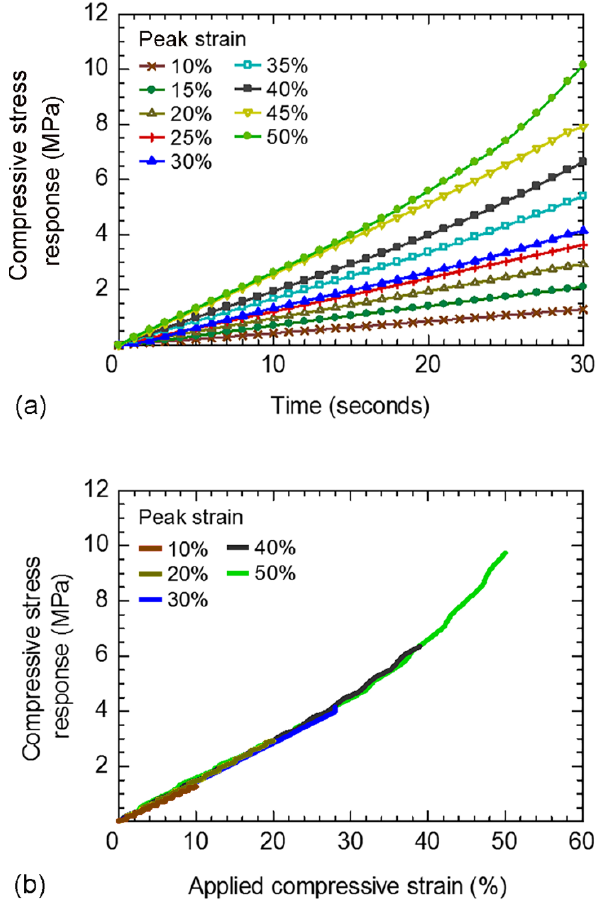
Figure 6. Hyperelastic period of stress relaxation test using disc-A: ( a ) compressive stress response vs. time; and ( b ) applied compressive strain vs. compressive stress response.